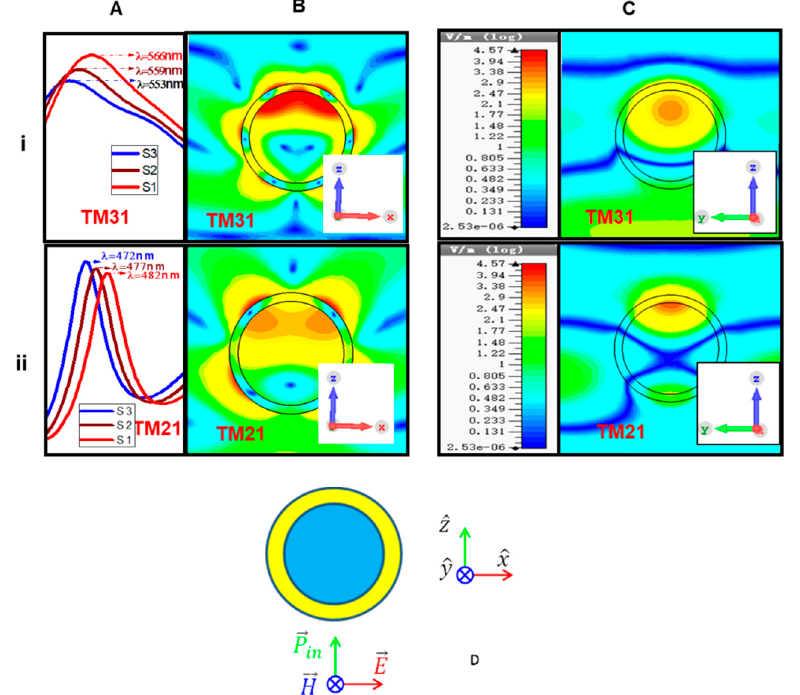
Figure 5. (Sample S2) Horizontal panels i and ii represent the higher ordered resonance modes at λ 1 = 470–483 nm and λ 2 = 553–567 nm, respectively, while vertical panels A, B and C ( A – C ) represent the absorption peak, electric field distribution in the YZ and XZ plane of the corresponding resonance modes respectively.